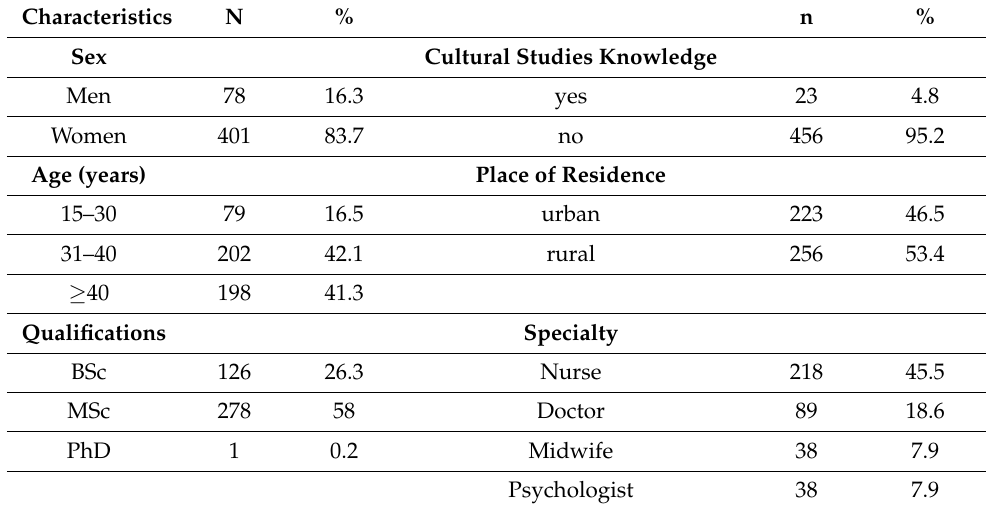
Table 1. Demographic